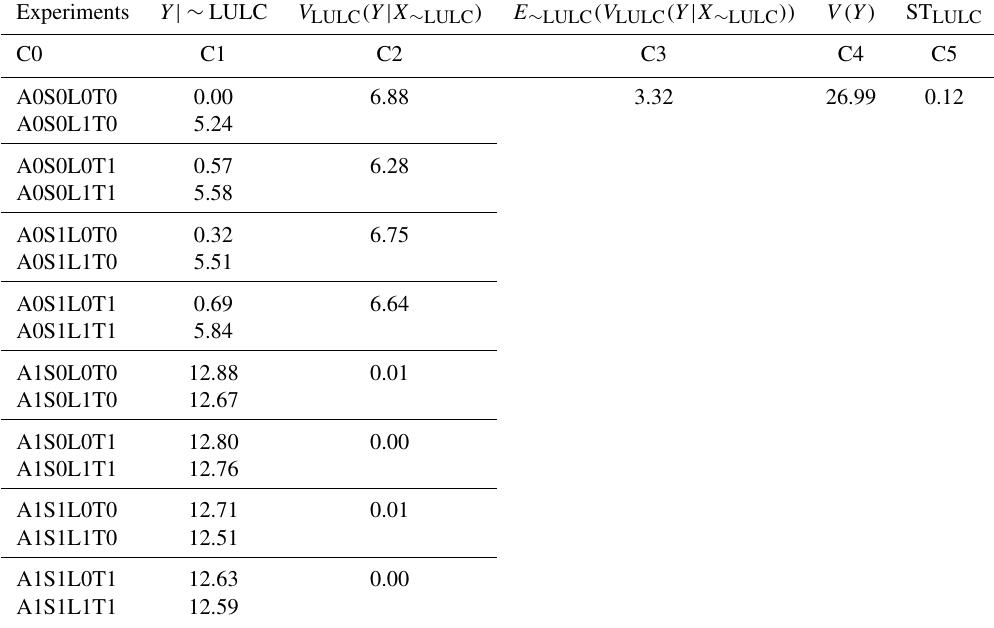
Table A1. Calculation of Sobol’ total sensitivity index.